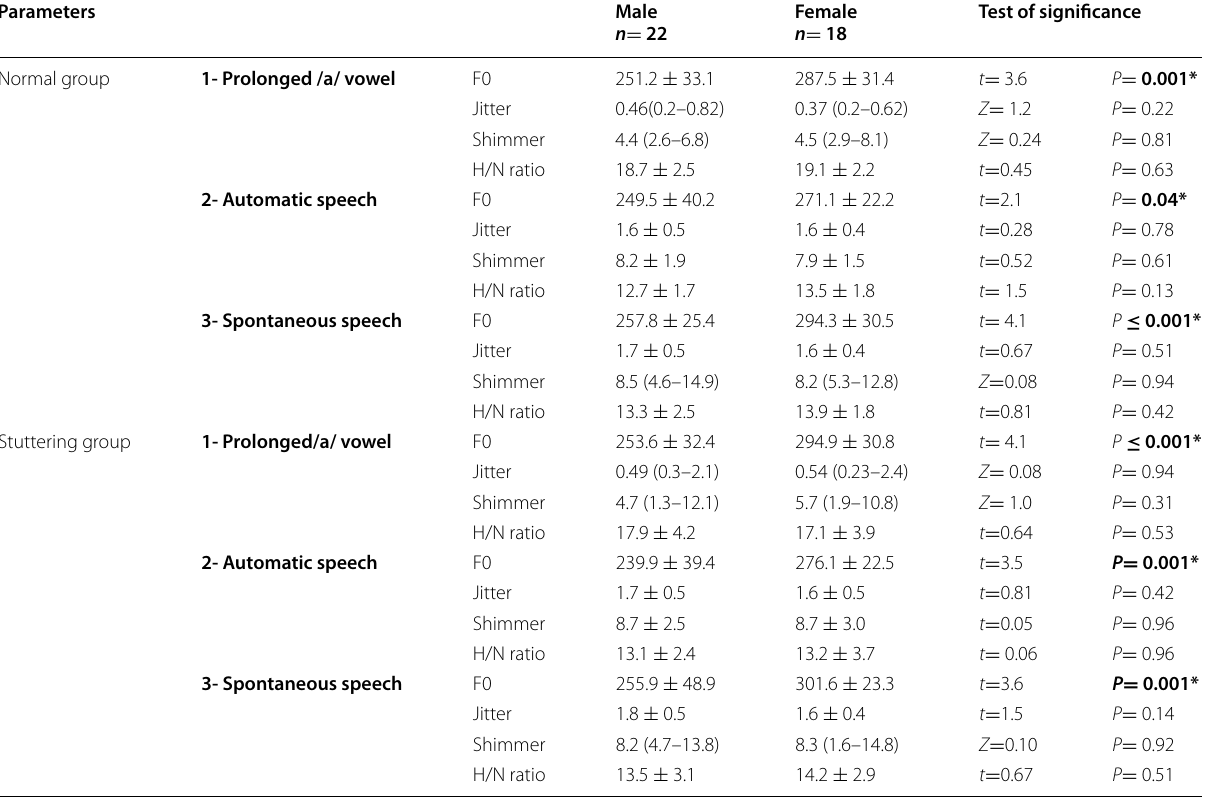
Data expressed as mean SD or median (minimum–maximum) ± *Significant p ≤